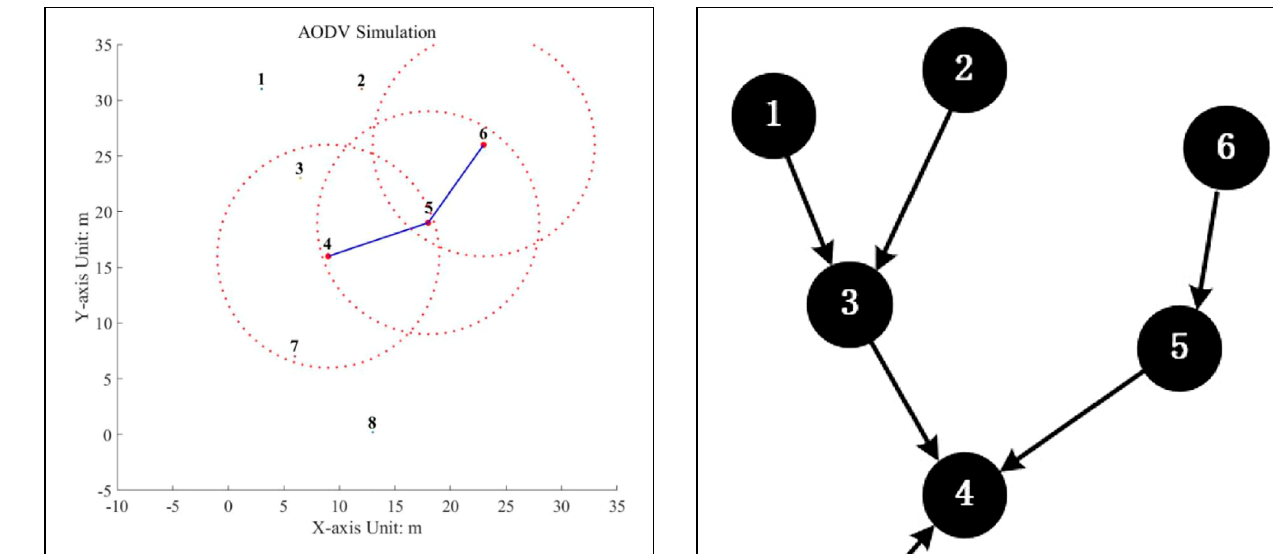
FIGURE 7 | Routing simulation diagram from node 6 to node 4.